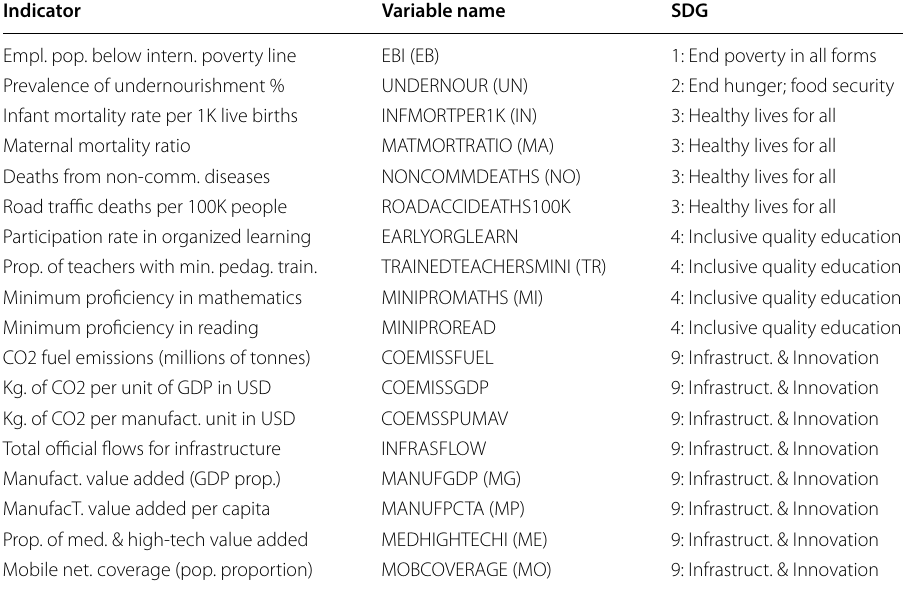
Table 1 Selected indicators, associated SDGs and number of cases used in the study Indicator Variable name SDG Empl. pop. below intern. poverty line EBI